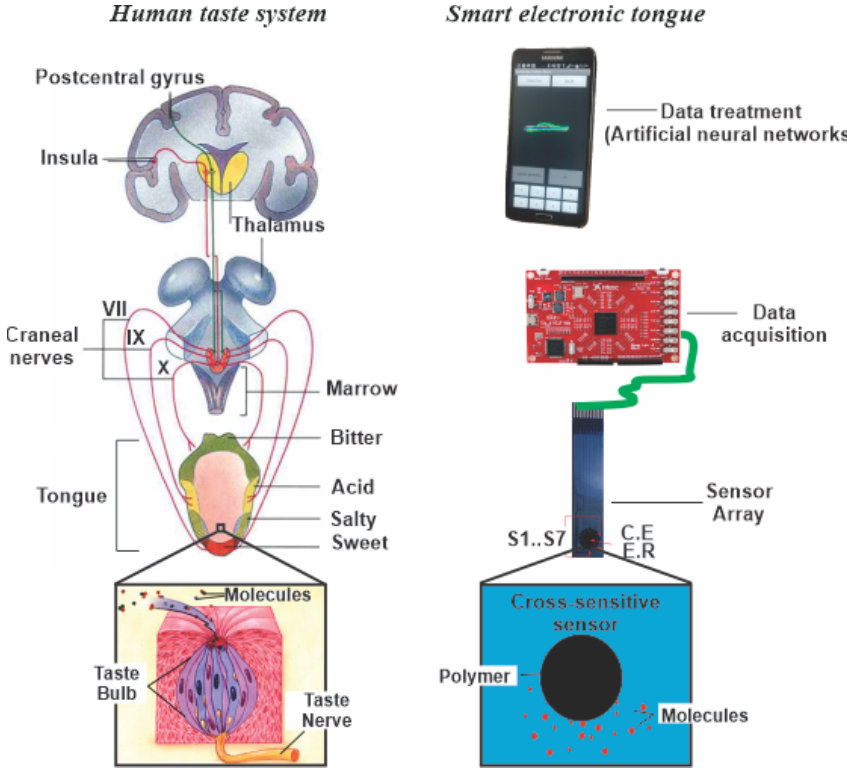
Figure 1. Functional similarities between the human taste system and an artificial system (smart electronic